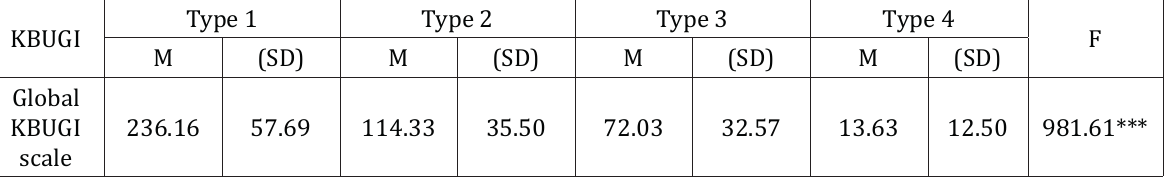
Table 3. Mean scores obtained by the four groups (types) of adolescents on the global KBUGI scale